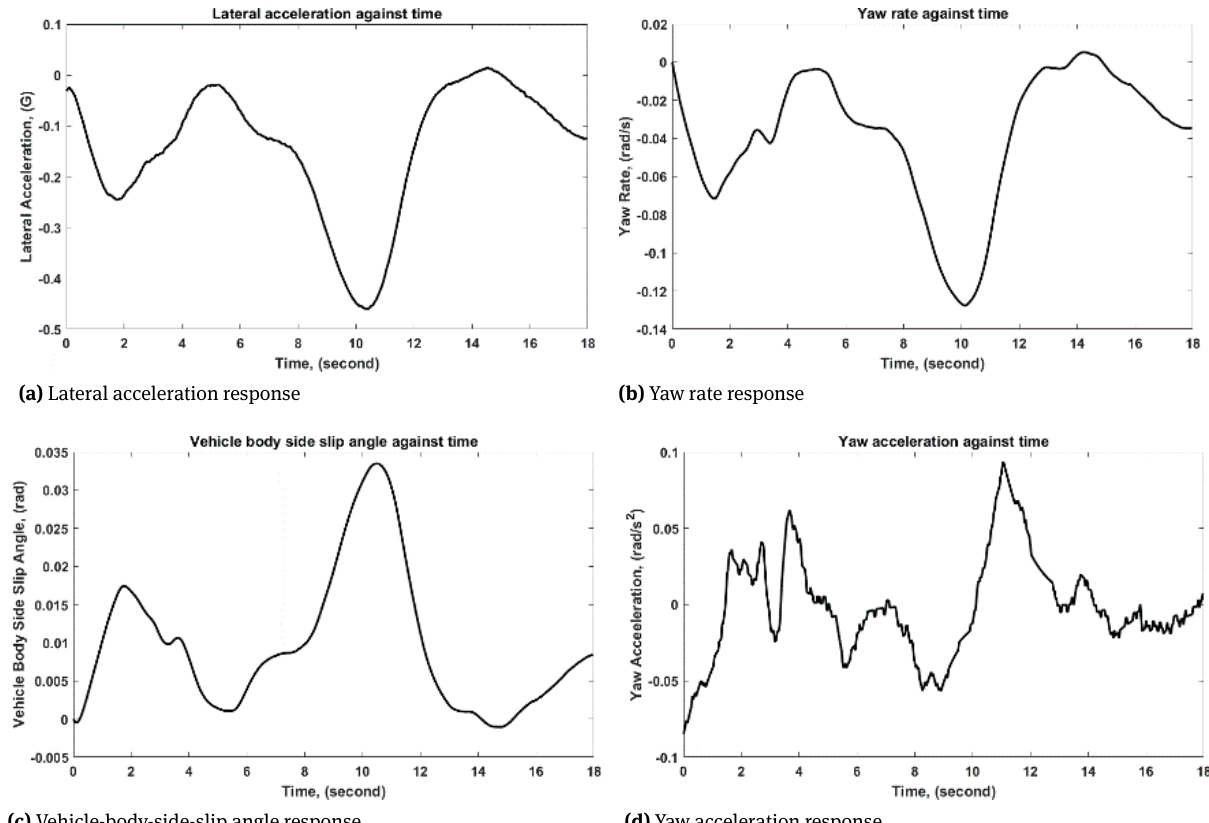
Figure 9: Results of simulated vehicle dynamics responses for clip #13 using model-based vehicle dynamics framework